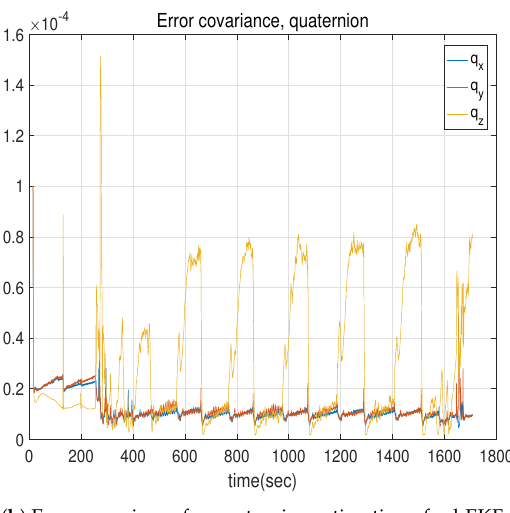
Figure 8. Comparison of error covariance for quaternion estimation between IEKF-lav and